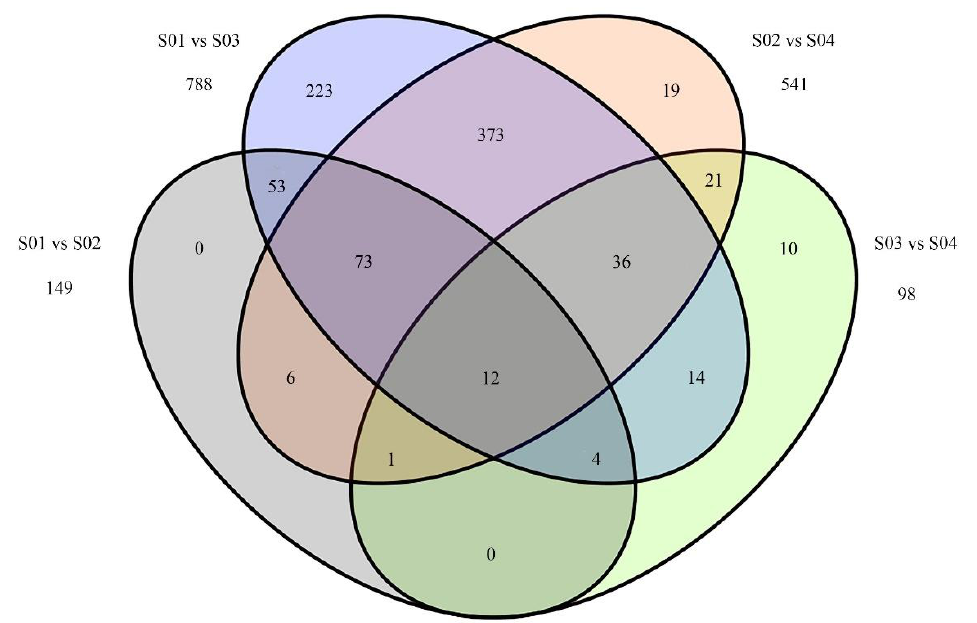
Figure 4. Venn diagram illustrating specific Phytophthora sojae -responsive miRNAs in Nannong 10-1